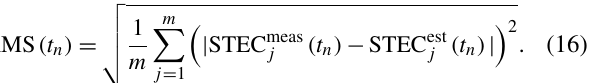
where m is the number of assimilated